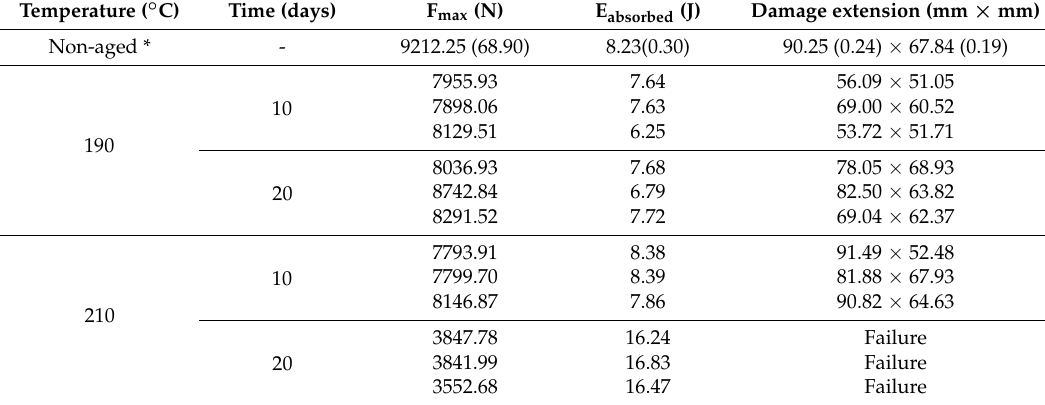
Table 2. Impact results and damage morphologies of impacted CFRP specimens. Standard deviation of non-aged specimens is depicted in brackets. * The results of non-aged samples were extracted from Reference